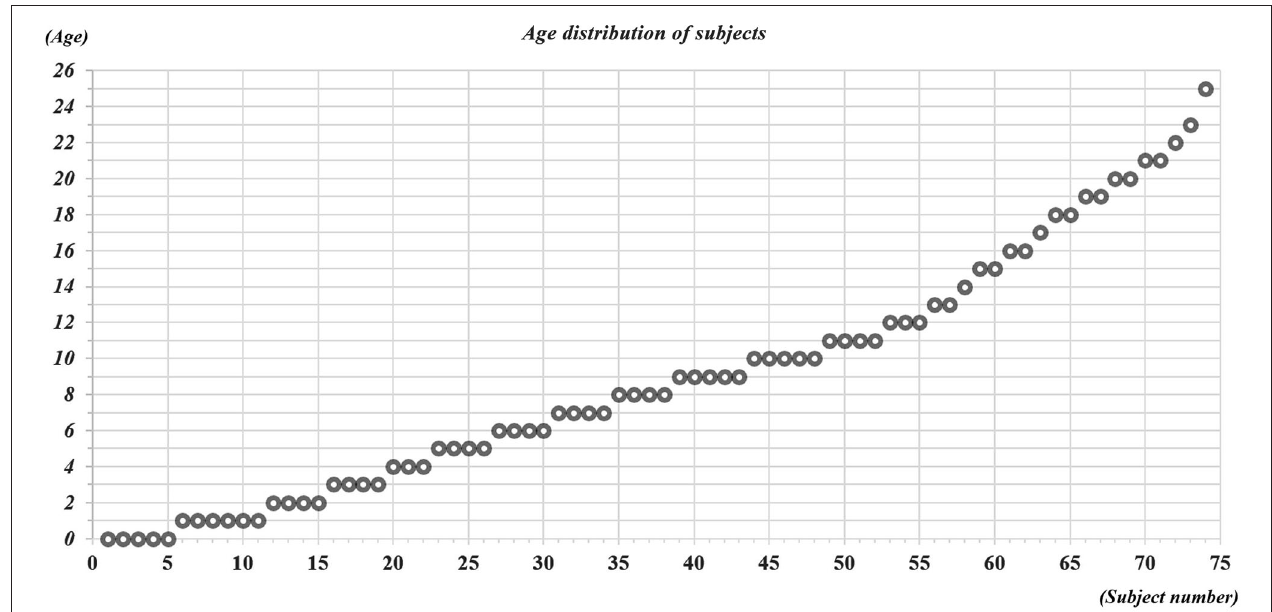
FIGURE 1 | Age distribution of subjects between 0–25 years old